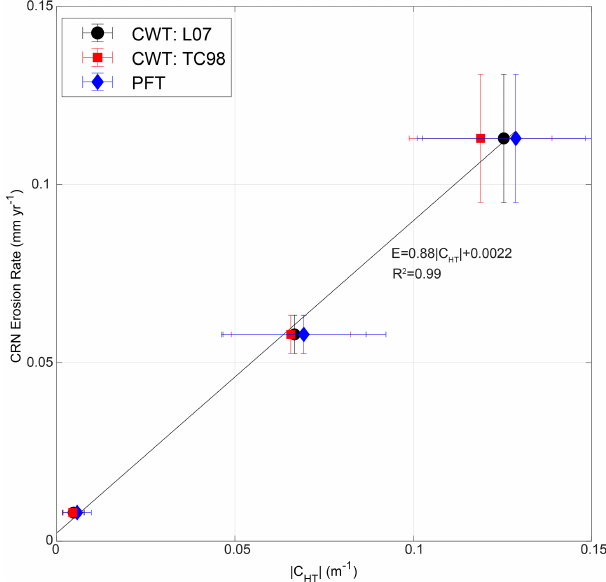
Figure 7. CRN erosion rate vs. C HT . CRN erosion rates for Bear Creek (slow E ), NFSR (moderate E ), and Hadsall Creek (fast E ) against the absolute value of C HT for the representative hilltop in each catchment. Filled symbols are mean E and C HT values, and error bars correspond to the standard deviation of C HT and external uncertainty in CRN erosion rate measurements (Tables 1, 3). Note that error bars may be smaller than the size of the mean symbol for Bear Creek samples. L07: Lashermes et al. (2007); TC98: Torrence and Compo